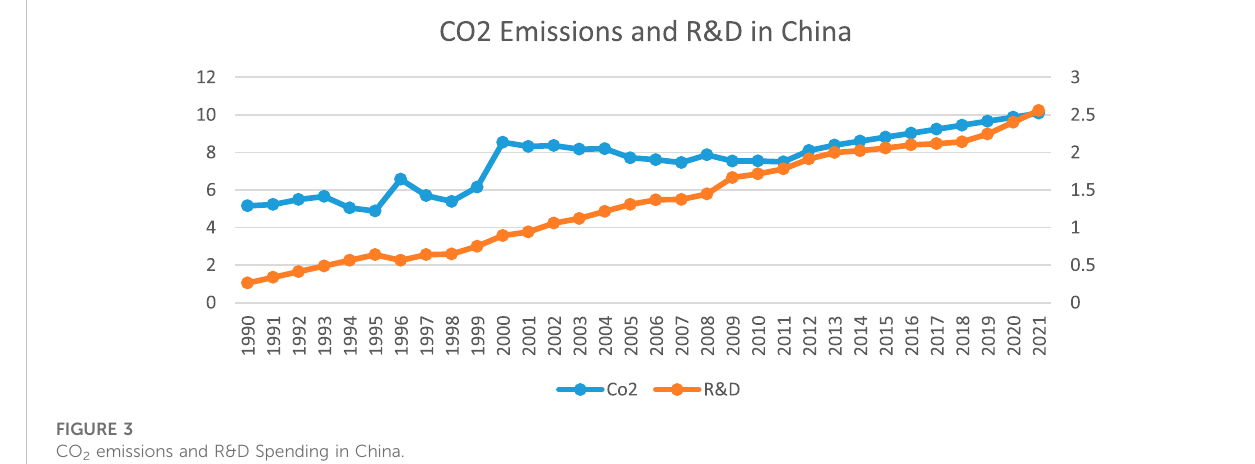
FIGURE 3 CO 2 emissions and R&D Spending in